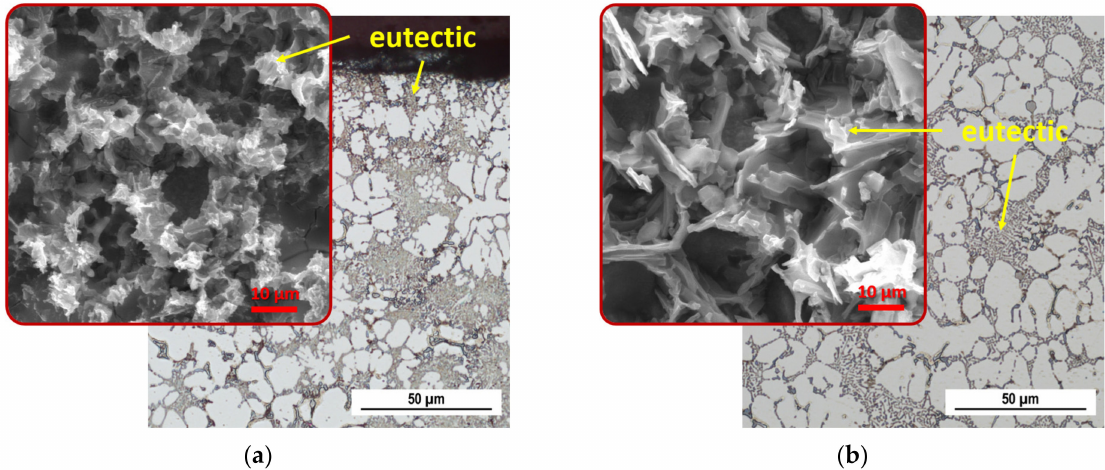
Figure 5. Images of the structure of the Z55 alloy casting in the cast state; OM, SEM: ( a ) surface region; ( b ) central region.